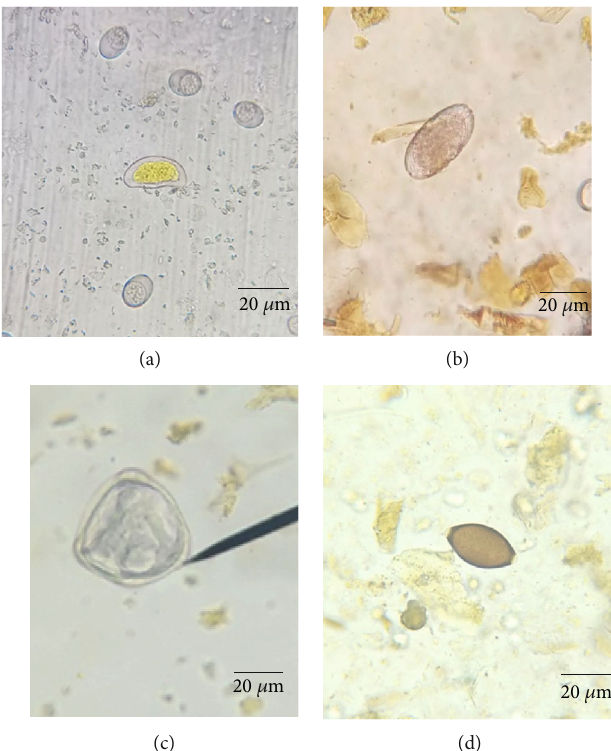
Figure 2: Parasite oocyst/eggs of sheep: (a) Eimeria spp. ( × 400), (b) Trichostrongyle ( × 100), (c) Moniezia expansa ( × 400), and (d) Trichuris spp. ( × 400).